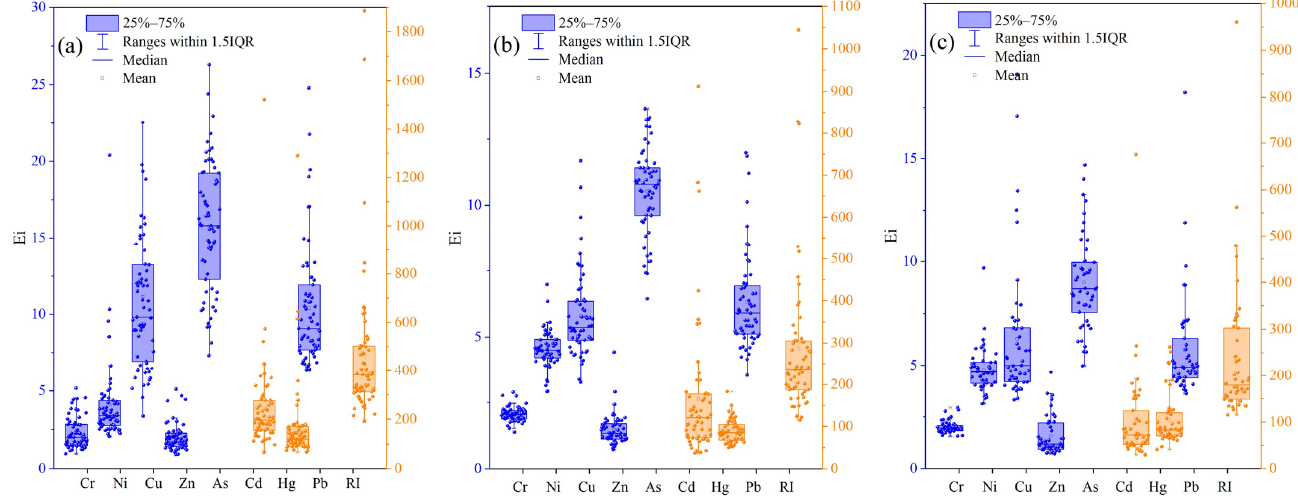
Figure 8. Box plots of E i r and RI in RD ( a ), RS ( b ) and sediment ( c ) samples from Zhengzhou.